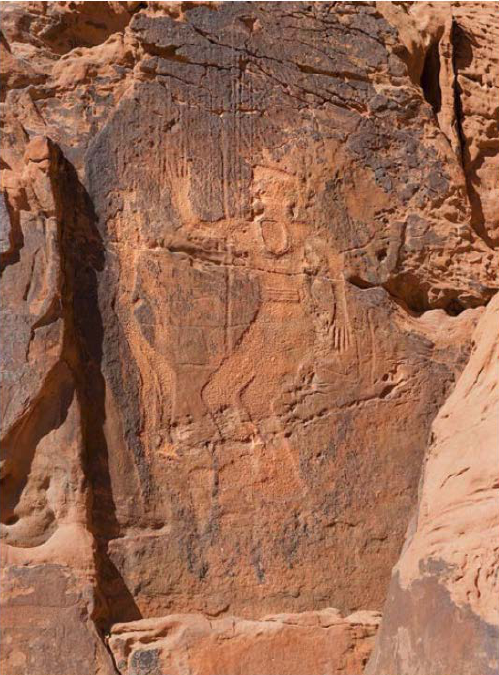
Figure 20. An elegant human figure at Jubbah, Northern Saudi Arabia. Local people called it the image of a king who is shown in sitting posture with his “attendant” standing in front of him.